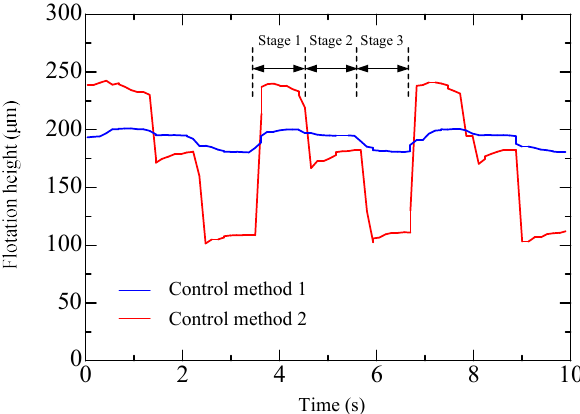
Figure 16. Fluctuations of the floating object by the two control